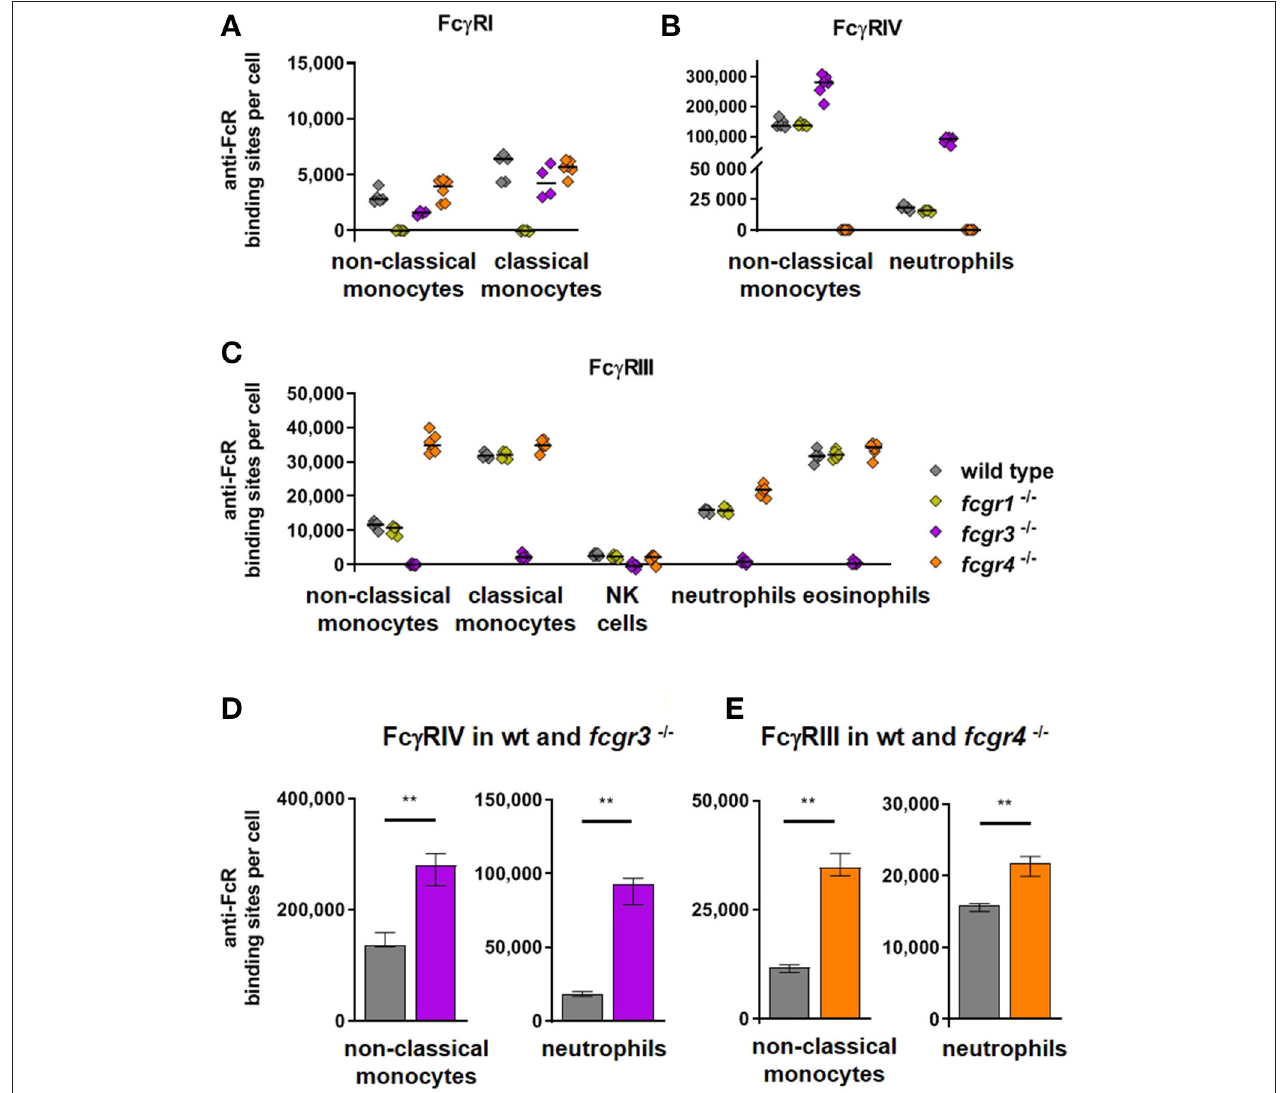
FIGURE 2 | Activating Fc gamma receptors on PBLs of wild type and activating Fc γ R knockout mice. In (A–C) individual values of anti-Fc γ R binding sites on cell populations prominently expressing the respective receptors are depicted for C57BL/6 wt mice and knockout mice lacking Fc γ RI, Fc γ RIII, or Fc γ RIV. Data are shown (A) for Fc γ RI on monocytes, (B) for Fc γ RIV on non-classical monocytes and neutrophils and (C) for Fc γ RIII on monocytes, NK cells, neutrophils and eosinophils. In (D–E) the anti-Fc γ R binding sites per cell are show for groups with prominently increased activating receptors on knockout compared to wild type mice, i.e., in (D) for Fc γ RIV in fcgr3 − / − knockout mice (violet bars) and in (E) for Fc γ RIII in fcgr4 − / − knockout mice (orange bars) in comparison to C57Bl/6 wild type mice (gray bars) on non-classical monocytes and neutrophils. n = 5–6; median ± IR; Mann-Whitney test for significance; ** p <